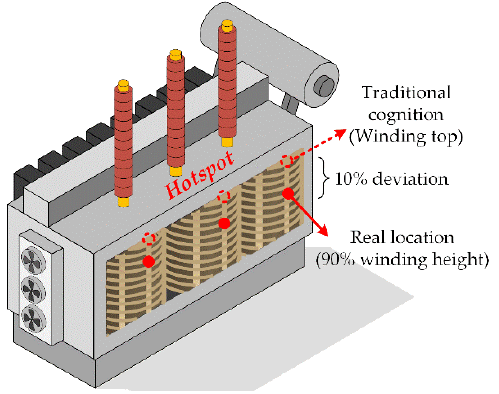
Figure 10. Hotspot real location compared to the traditional cognition.